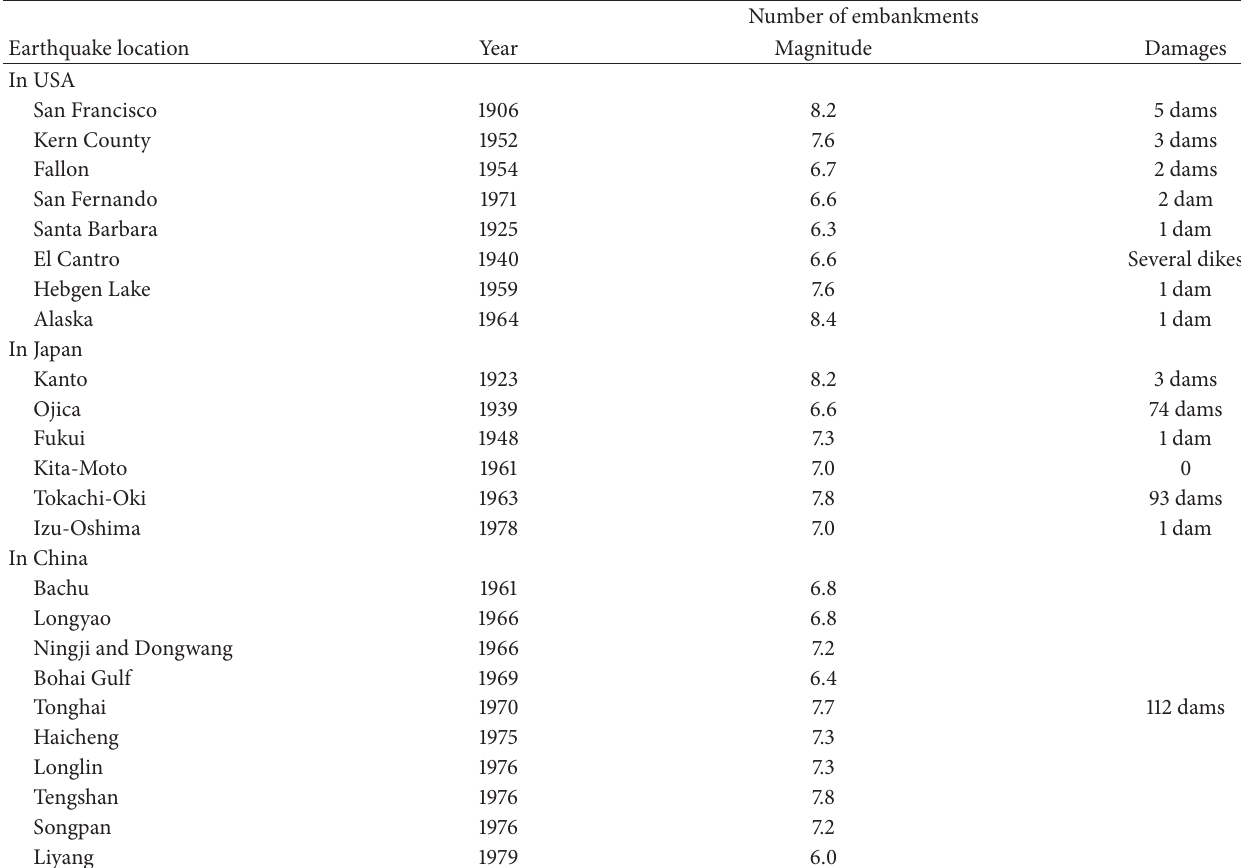
Table 1: Examples of destructed dams since 1900 to 1980